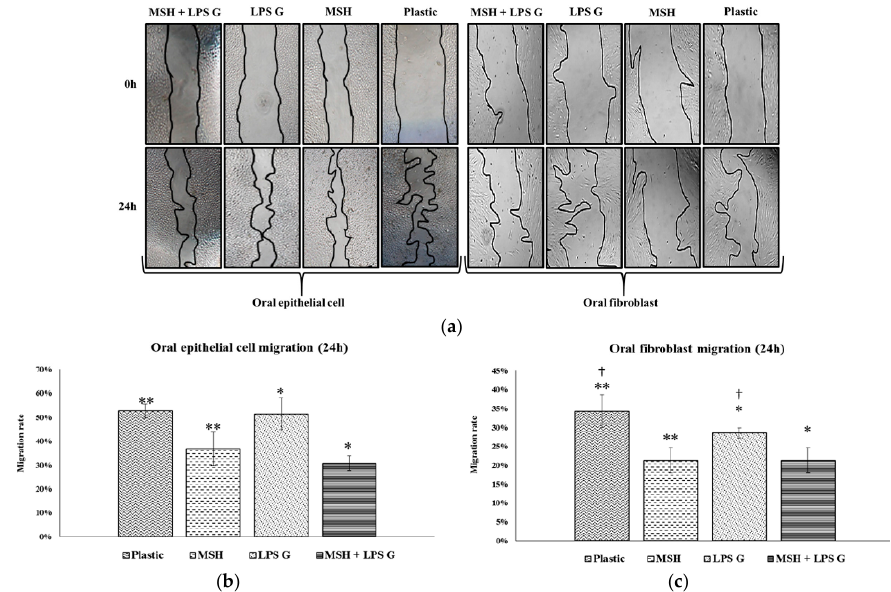
Figure 3. Oral epithelial cell and fibroblast migration. Representative images of scratch closure in the in vitro scratch assay ( a ). Quantification of oral epithelial cell ( b ) and fibroblast migration ( c ) at 24 h on cell culture ( n = 5). Data are expressed as mean ± SD. †: di ff erence between non ‐ stimulated and stimulated cells, p < 0.05; **: difference between non stimulated cells with or without PGA ‐α‐ MSH; *: difference between stimulated cells with or without PGA ‐α‐ MSH, p < 0.05.